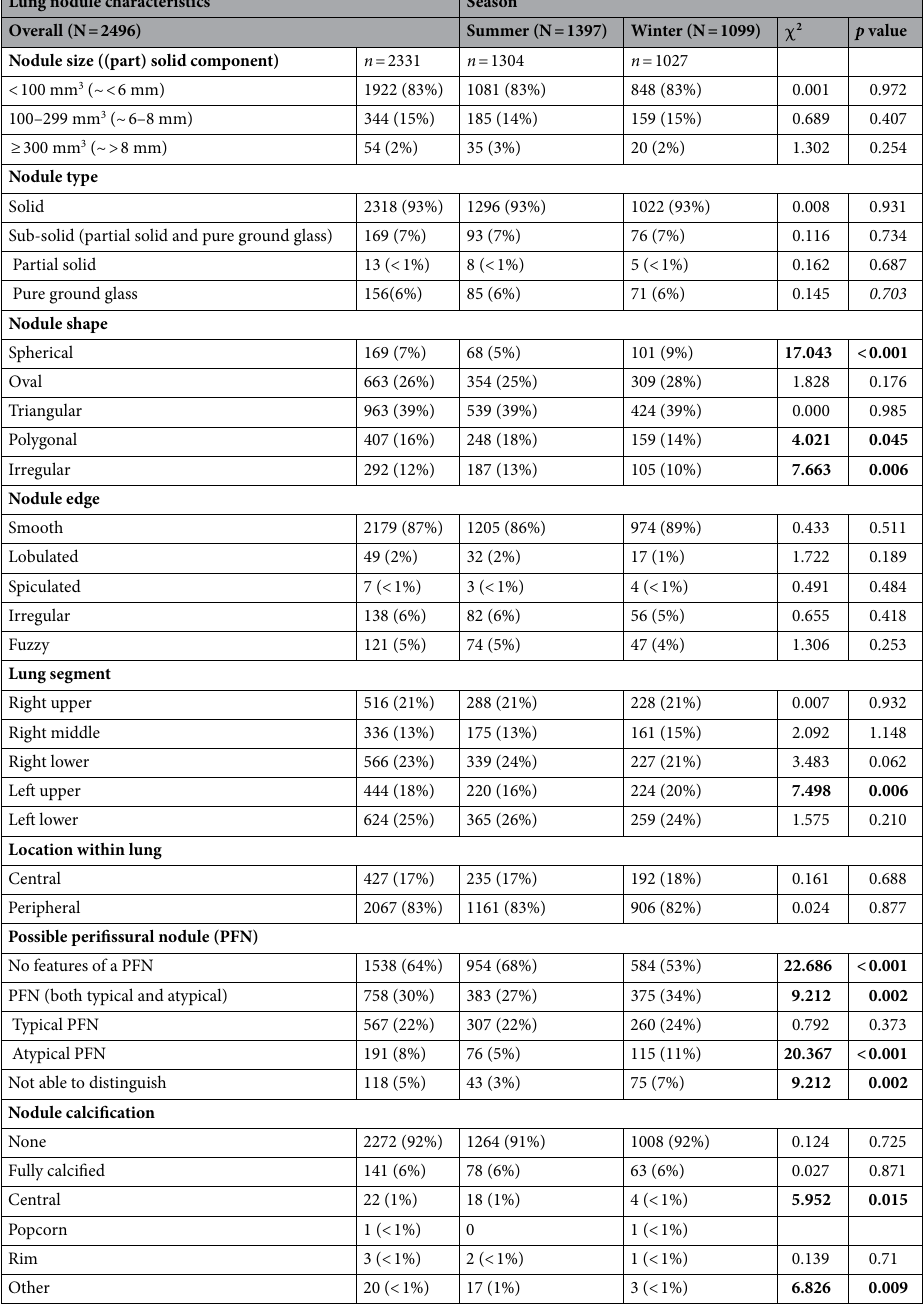
Table 3. Nodule characteristics and seasonal variation in size and characteristics. PFN perifissural nodule; missing data (number cases): nodule size solid nodules (3), nodule type (6), nodule shape (2), nodule edge (2), lung segment (10), location within lung (2), possible pfn (82), calcification (37). Significant seasonal variation in bold